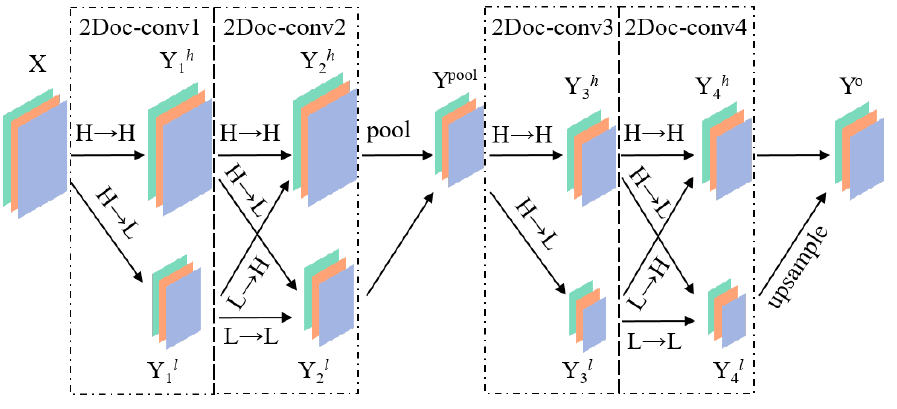
Figure 2. The schematic of the overall structure of the 2D octave convolutional